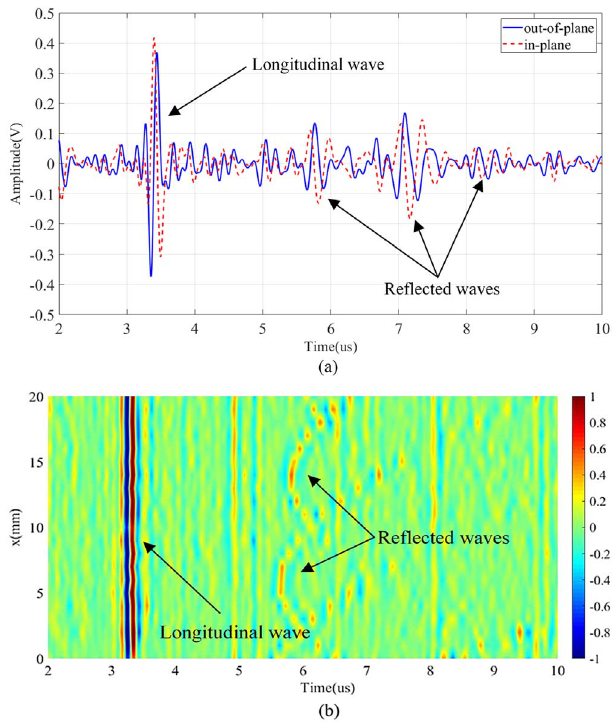
Figure 7. (a) A typical fi ltered A-scan signal acquired at x = 16 mm. (b) B-scan results part of the out-of-plane signals S j = 1, 2, ... , N ). jj (